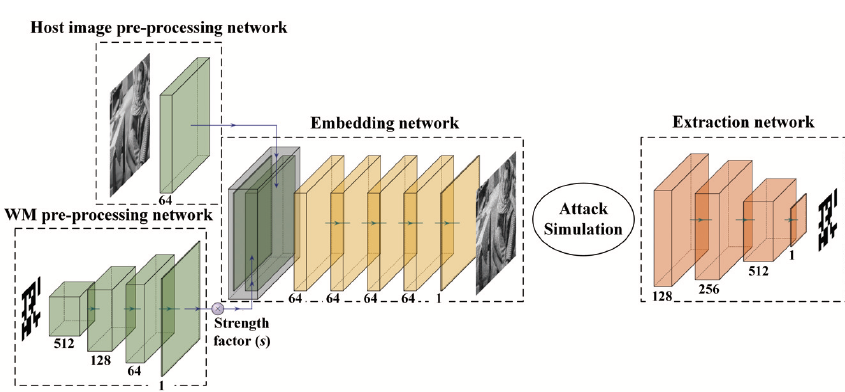
Figure 1. The structure of the used watermarking